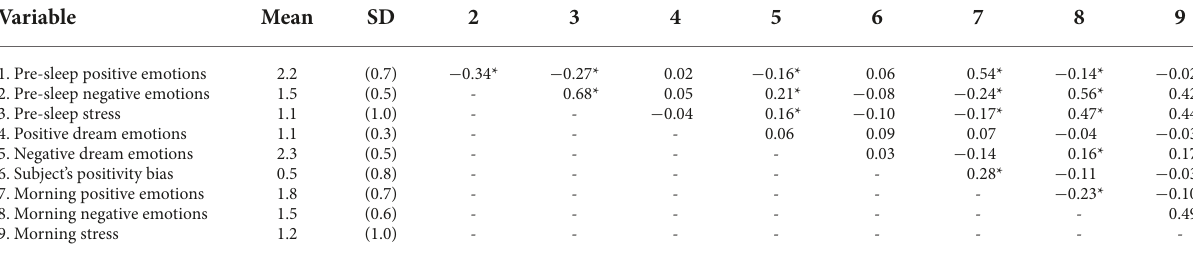
TABLE 2 Means, standard deviations, and correlations among the variables in those who had negative dream nights. Variable